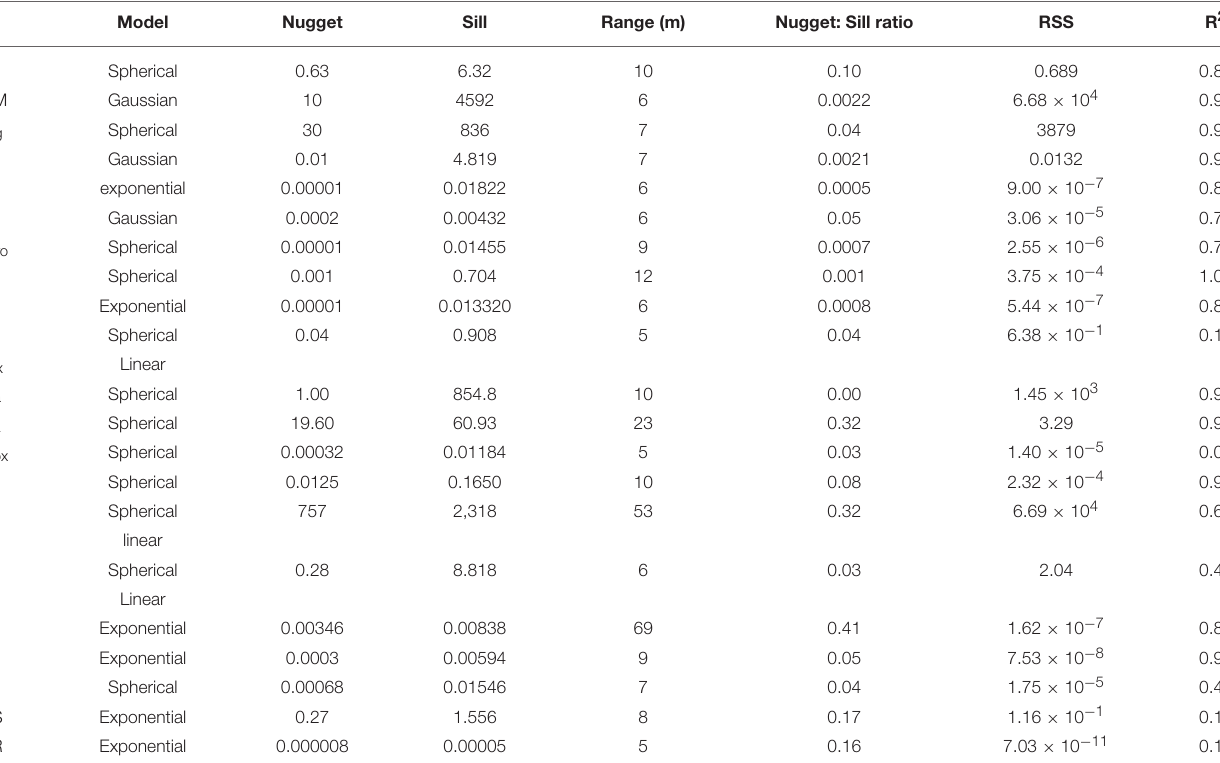
TABLE 8 | Spatial correlation of gravimetric water content (GW), soil organic matter, available plant nutrients, total and oxalate extractable elements in the surface of a rewetted peatland.